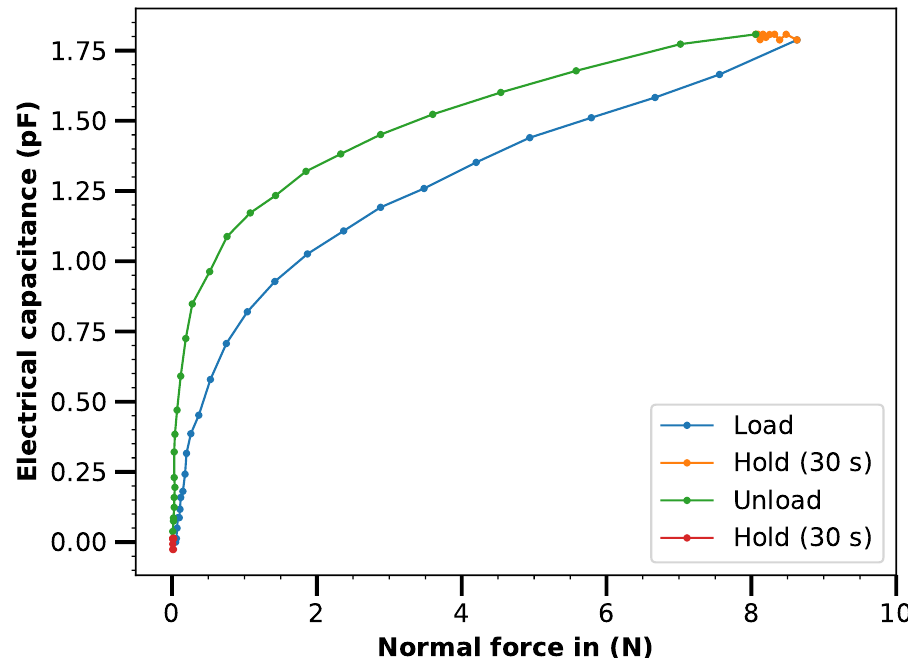
Figure 9. Characteristics of the laser-structured pressure sensor. The absolute change in capacitance compared to the basic capacitance is